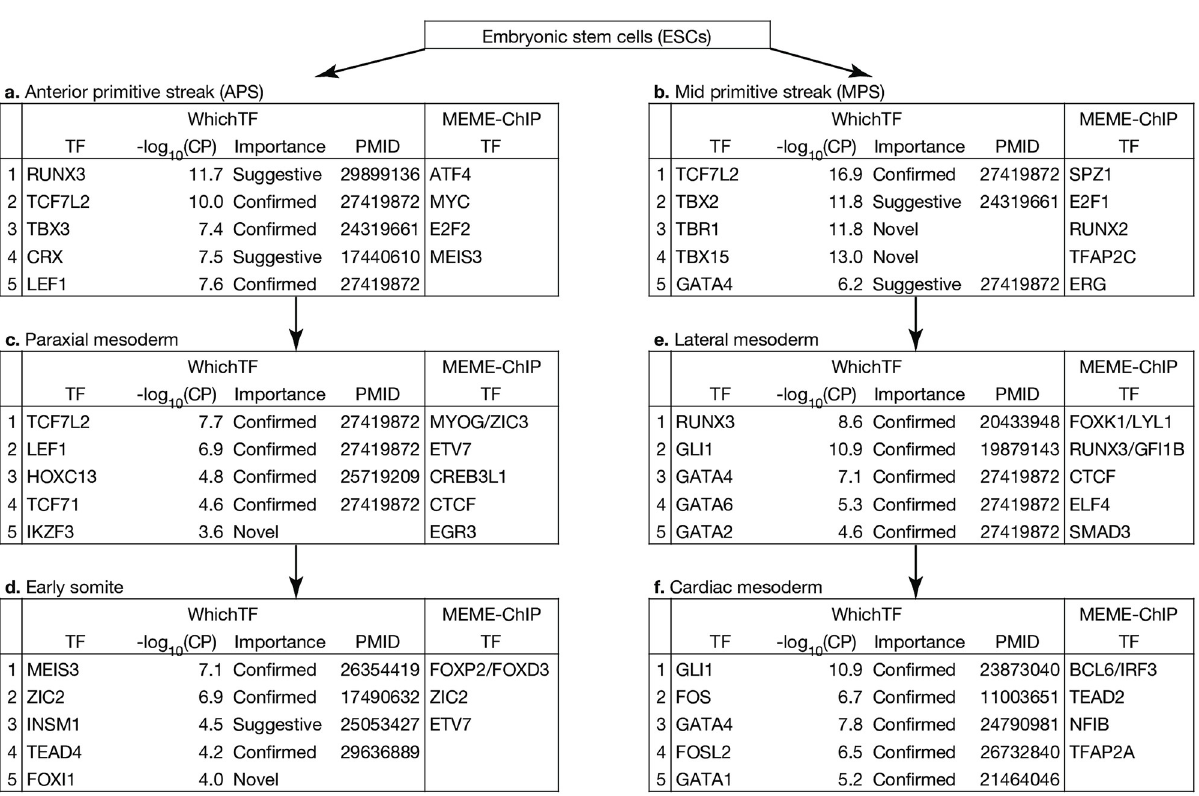
Fig 3. Differential WhichTF analysis identifies differentially dominant TFs compared to immediate progenitor cells along experimentally derived human mesoderm development pathways from ATAC-seq data. The top 5 TFs with their corresponding statistical significance, negative log 10 conditional probabilities, -log 10 (CP), are shown. The results from a MEME-ChIP differential analysis are shown for comparison. The importance and PubMed ID (PMID) columns indicate whether (i) existing literature supports the identified TFs (confirmed); (ii) literature reports closely related factors, such as co-factors and functionally related family members, or the identified TFs in a related context (suggestive); or (iii) novel. Differential WhichTF and differential MEME-ChIP are found to produce very different predictions. The abundance of confirmed WhichTF predictions (here and in previous figures) makes suggestive and novel predictions more